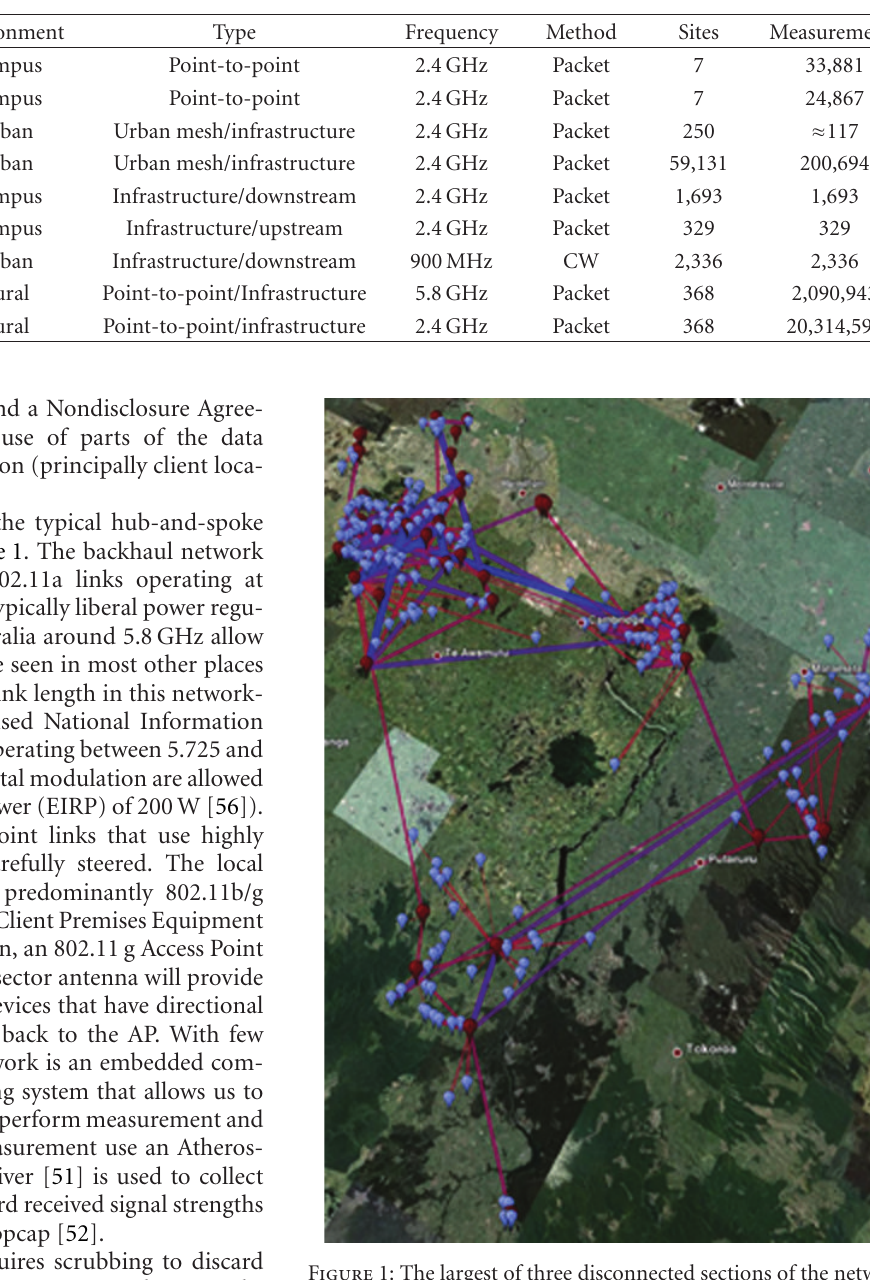
Table 2: Summary of data sets.